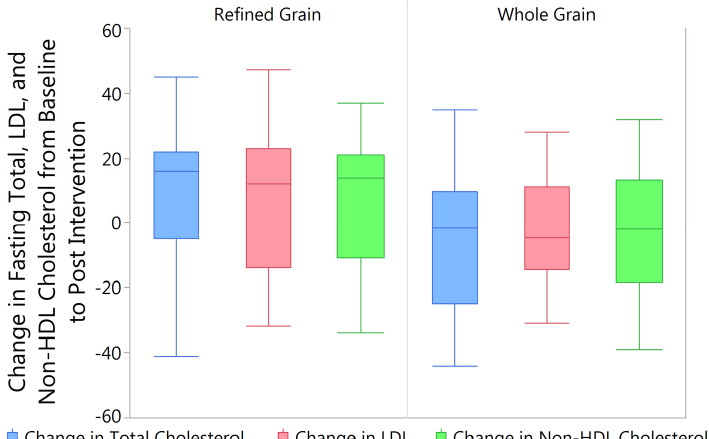
Figure 4. Consumption of the Whole or Refined Grain Market Basket Related to Change in Fasting Total, LDL, and Non-HDL Cholesterol. Consumption of the WG market basket was significantly associated with lower fasting levels of total cholesterol ( p = 0.018), LDL cholesterol ( p = 0.035), and non-HDL cholesterol ( p = 0.047) when compared to subjects that consumed the RG market basket. When comparing fasting lipid levels to percent consumption of the market baskets while controlling for baseline levels no significant differences were seen in the change in total (RG p = 0.179;